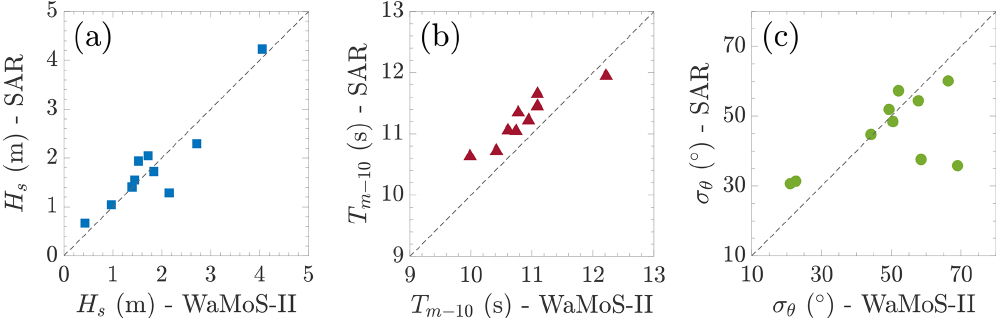
Figure 10. Comparison of integrated parameters (WaMoS-II versus SAR): significant wave height ( H s , panel a ), energy wave period ( T m − 10 , panel b ), and wave directional spreading ( σ θ , panel c